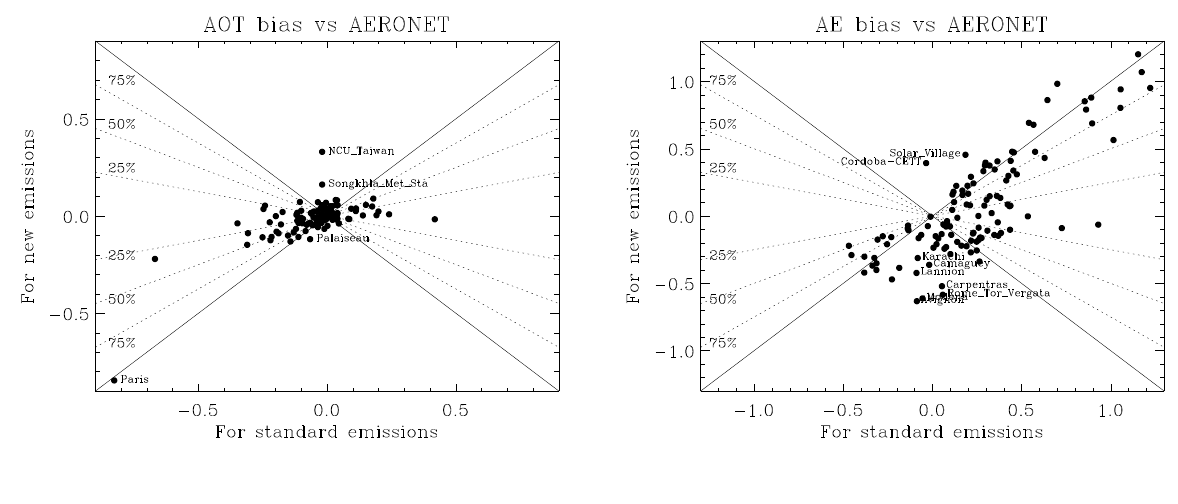
Figure 7. The AOT and AE bias (last three weeks of January 2009) in the new emissions forecast vs the standard emissions forecast for individual AERONET sites.